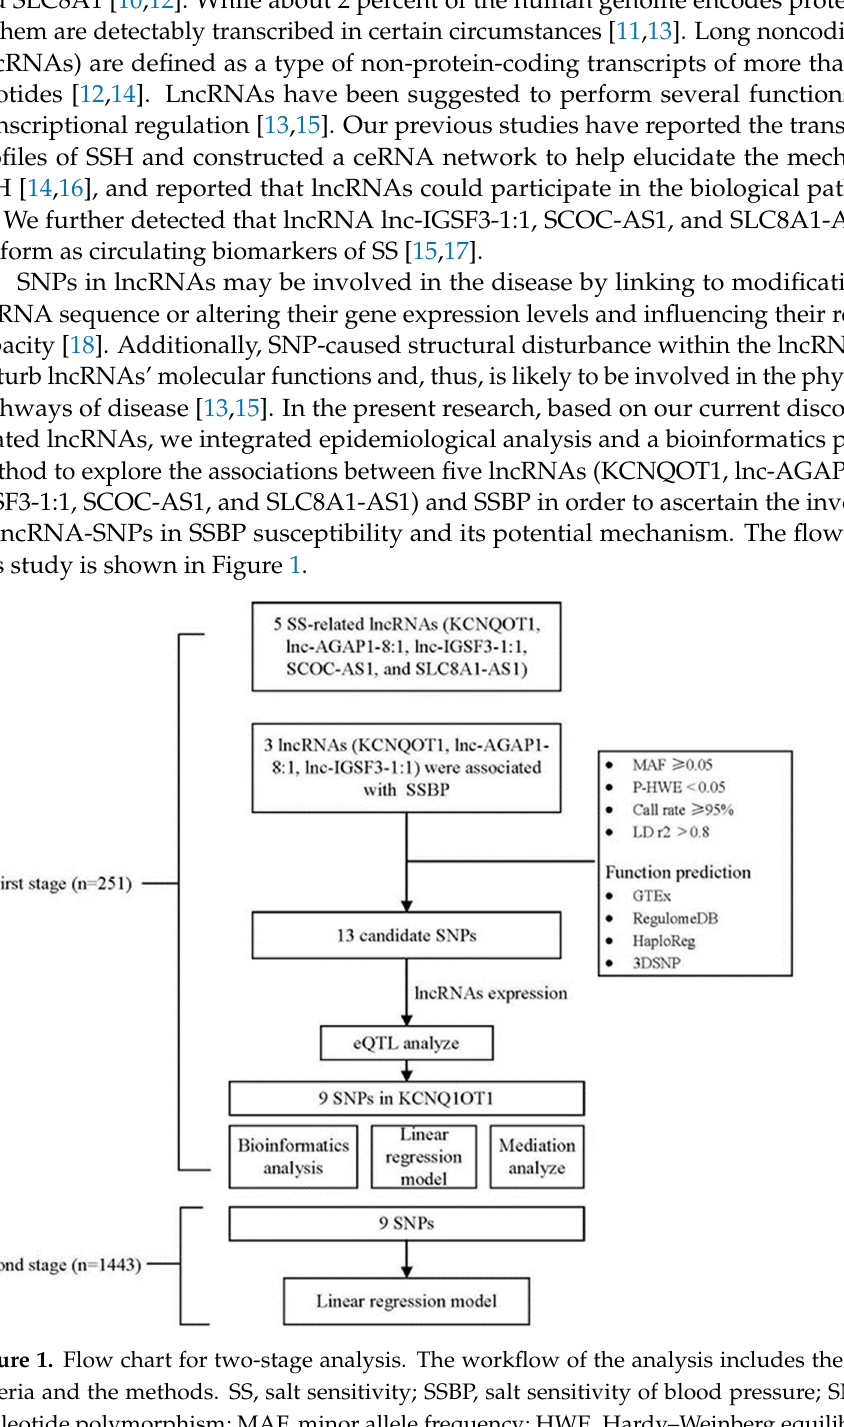
Figure 1. Flow chart for two-stage analysis. The workflow of the analysis includes the screening criteria and the methods. SS, salt sensitivity; SSBP, salt sensitivity of blood pressure; SNP, single- nucleotide polymorphism; MAF, minor allele frequency; HWE, Hardy–Weinberg equilibrium; LD, linkage disequilibrium; eQTL, expression quantitative trait loci.